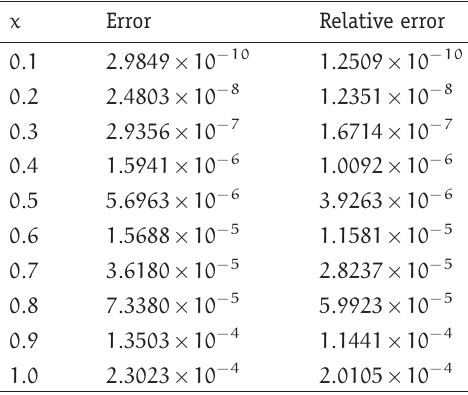
Table 3.3. Error obtained upon using six iterations of the Laplace transform decomposition